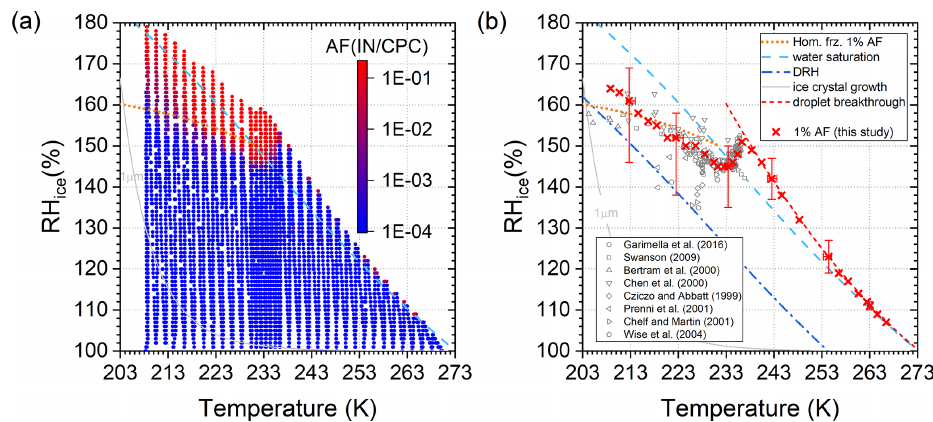
Figure 4. (a) Activated fraction of 200nm ( NH 4 ) 2 SO 4 particles and (b) 1% AF in comparison to literature data (references indicated in the figure legend) and the parametrization given in Koop et al. (2000). Lines indicate the Koop line for homogeneous ice formation, water saturation, deliquescence relative humidity (DRH, Seinfeld and Pandis, 2006), droplet breakthrough and 1µm ice crystal growth conditions. The range of experimental variability in RH i and T is shown at 10K intervals.